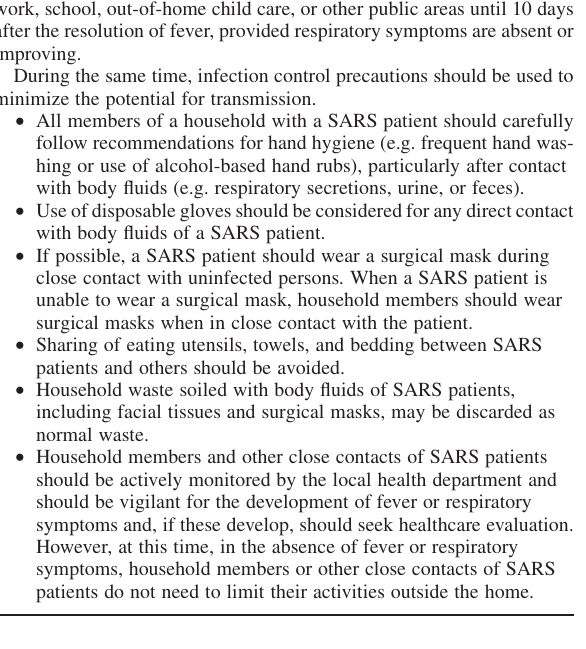
TABLE I CDC guidelines for the management of patients diagnosed with SARS (available at URL http://www.cdc.gov/ncidod/sars/